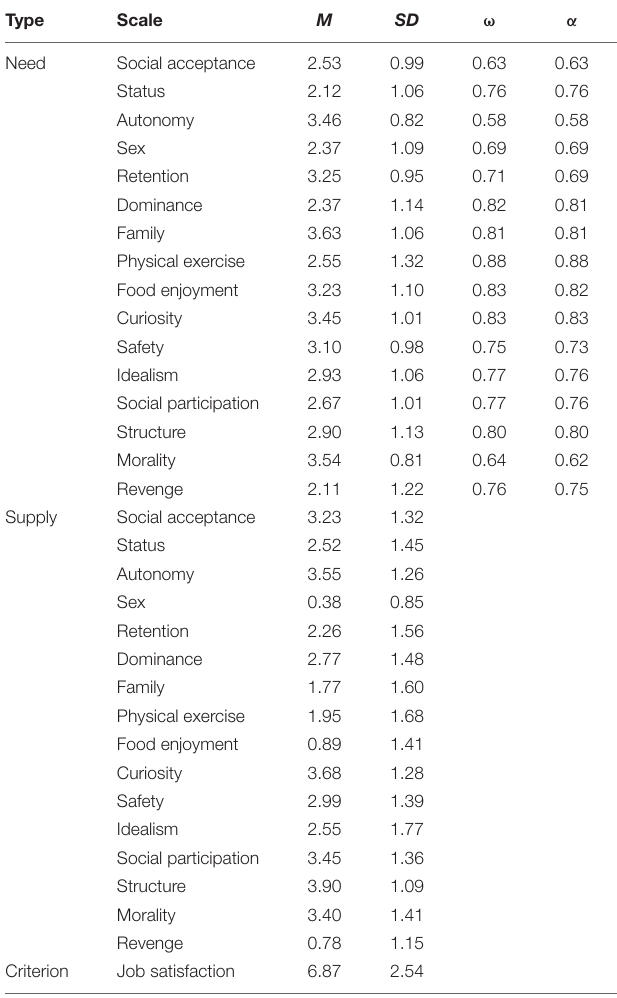
TABLE 2 | Descriptive statistics for the variables used in this study. defined by an intercept parameter ( p 10 ) and a slope parameter ( p 11 ). For convex- and saddle-shaped response surfaces, the first principal axis represents the line of greatest upward